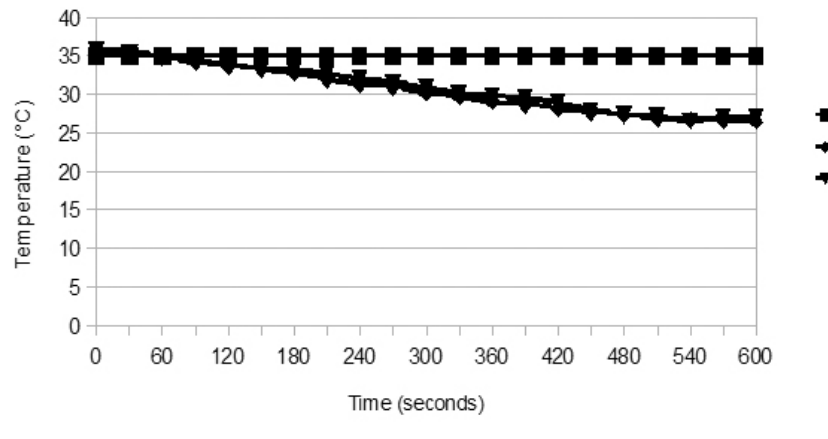
Figure 3B - Temperature versus infusion time with hilar clamped (infusion rate = 1000 cc/hour).